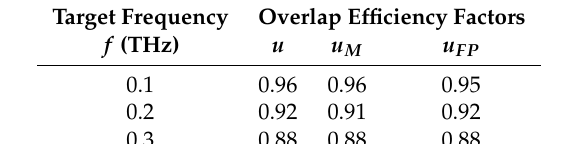
Table 4. Theoretical overlap efficiency factor u estimated using Equation (6) and measured overlap efficiency factors u FP and u M from signals shown in Figure 8a–f, obtained using Fabry–Perot and Michelson interferometer, respectively.